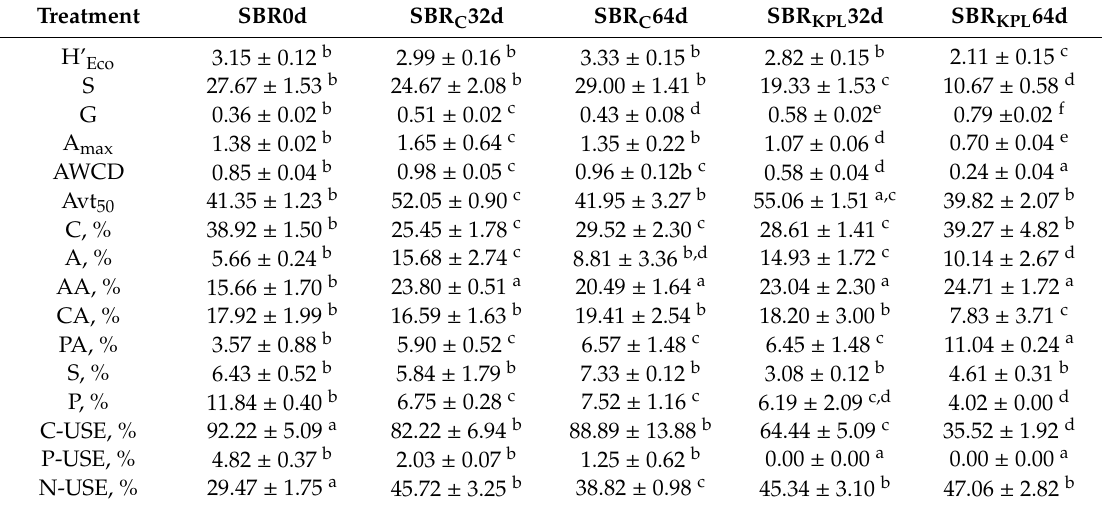
Table 5. Values of functional capacity indices; kinetic parameters—Amax; Avt 50 ; and usage of carbon substrate guilds for the untreated AS and treated with KPL.